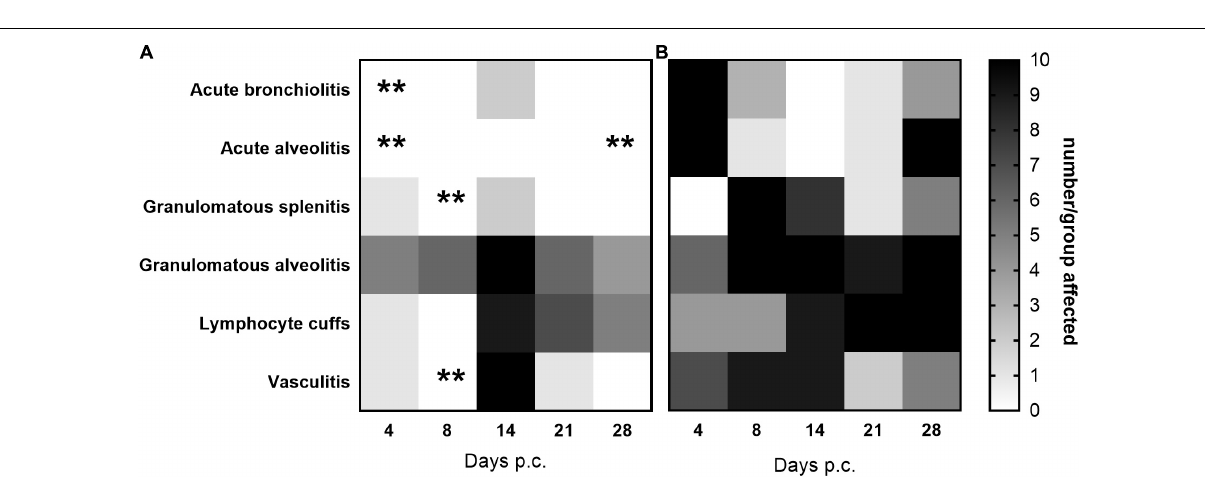
Frontiers in Microbiology |